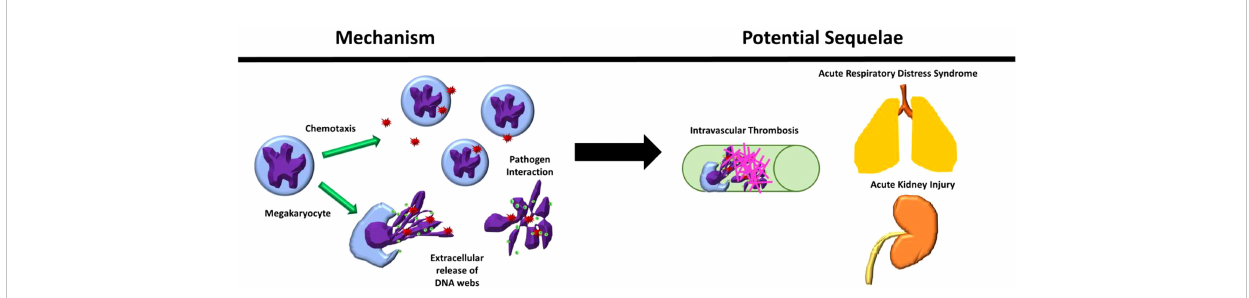
FIGURE 6 Megakaryocyte immune behaviors observed and their possible sequelae in physiological systems. Megakaryocytes (MKS) were observed to chemotax and release extracellular chromatin webs in response to pathogenic stimuli and interact directly with pathogens. These behaviors, in combination with their presence in increased amounts in the blood and peripheral organs during severe in fl ammatory conditions, such as sepsis, may contribute to the response to pathogenic stimulus, including the contribution to the development of intravascular thrombosis in peripheral organs, such as the lungs and the